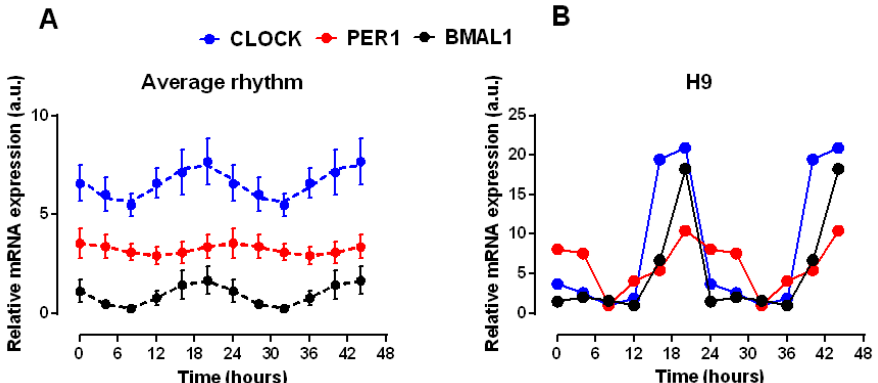
Figure 3. Circadian changes in the expression of Bmal1 , Clock and Per1 genes in smooth muscle explants from human colon. ( A ) Expression of Clock , Per1 and Bmal1 genes in colon muscle explants from 10 individuals was determined every 4 h during 24 h starting 8 a.m. the day following sample isolation. Data were averaged and simple cosinor analysis was performed (dashed line, cosine fitted function). For the sake of clarity Clock and Bmal1 have been shifted upward (2.5 units) and downward (1.5 units) respectively to avoid overlap. ( B ) A representative record of genes expression. For display purpose, in both panels the 24 h recorded period is represented twice.